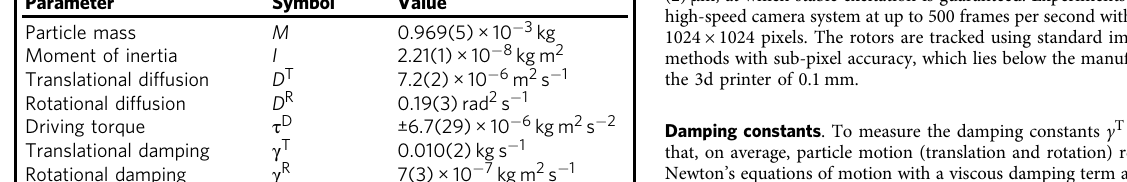
Table 1 Simulation parameters obtained from experiment